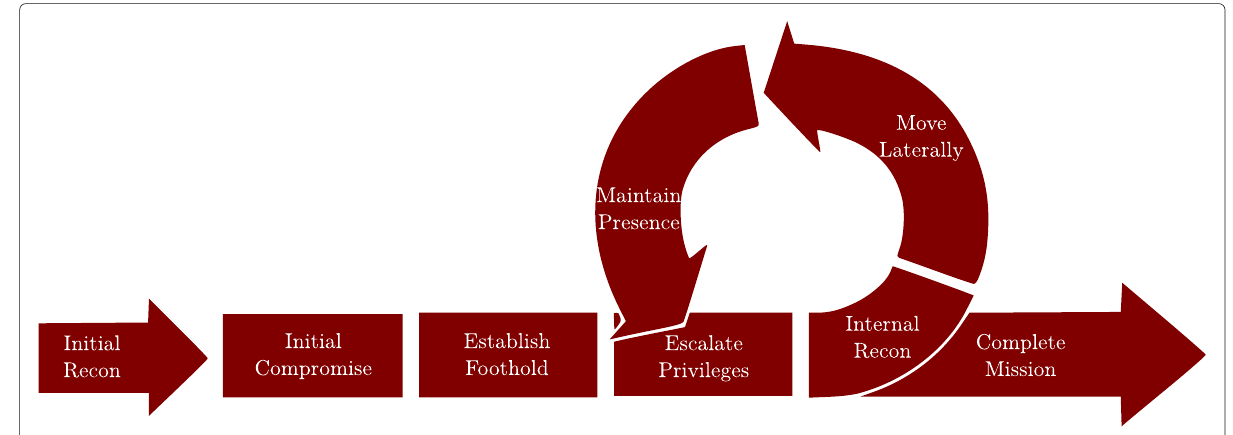
Fig. 2 The APT life-cycle by Mandiant